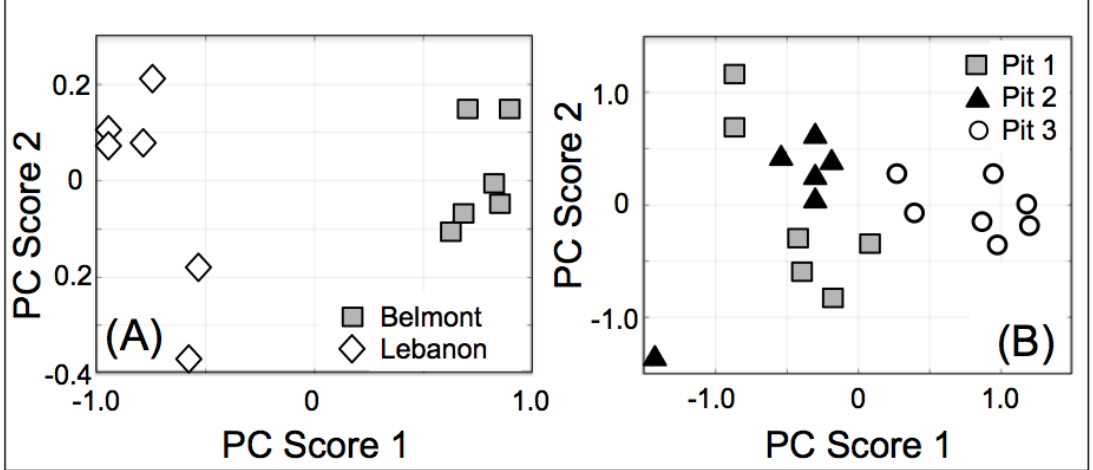
Figure 4. Principal component score plots of the fusion feature vectors for the two New Hampshire locations (A) and at the three Belmont site pits